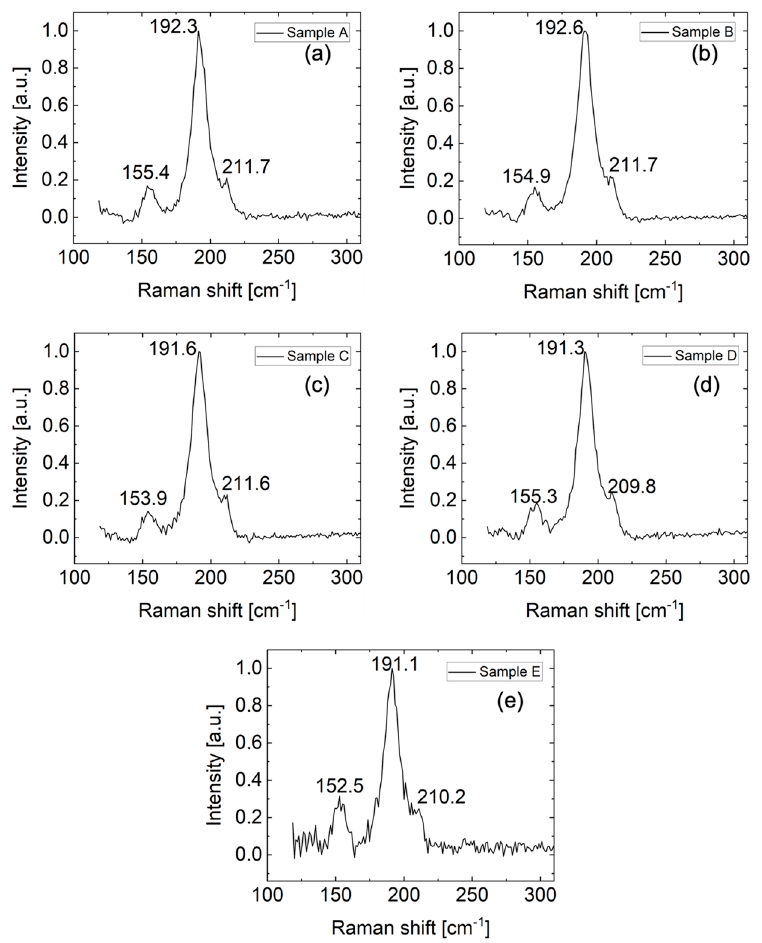
Figure 4. Antimony selenide Raman spectra grown on ( a ) CdS, ( b ) CdS:F, ( c ) CdSe, ( d ) As 2 S 3 and ( e ) ZnCdS.